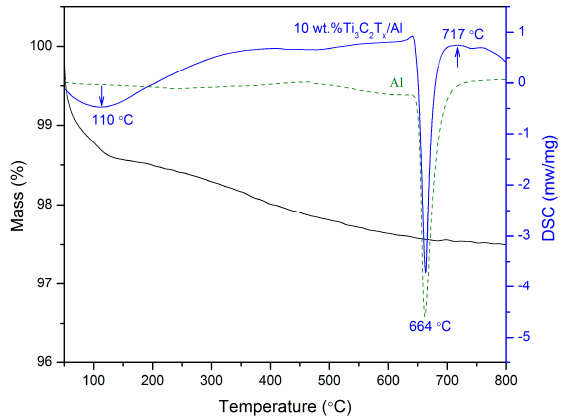
Figure 1. DSC analysis for 10 wt % Ti 3 C 2 /Al mixture in the temperature range 50–800 ◦ C, together with Al for comparison.